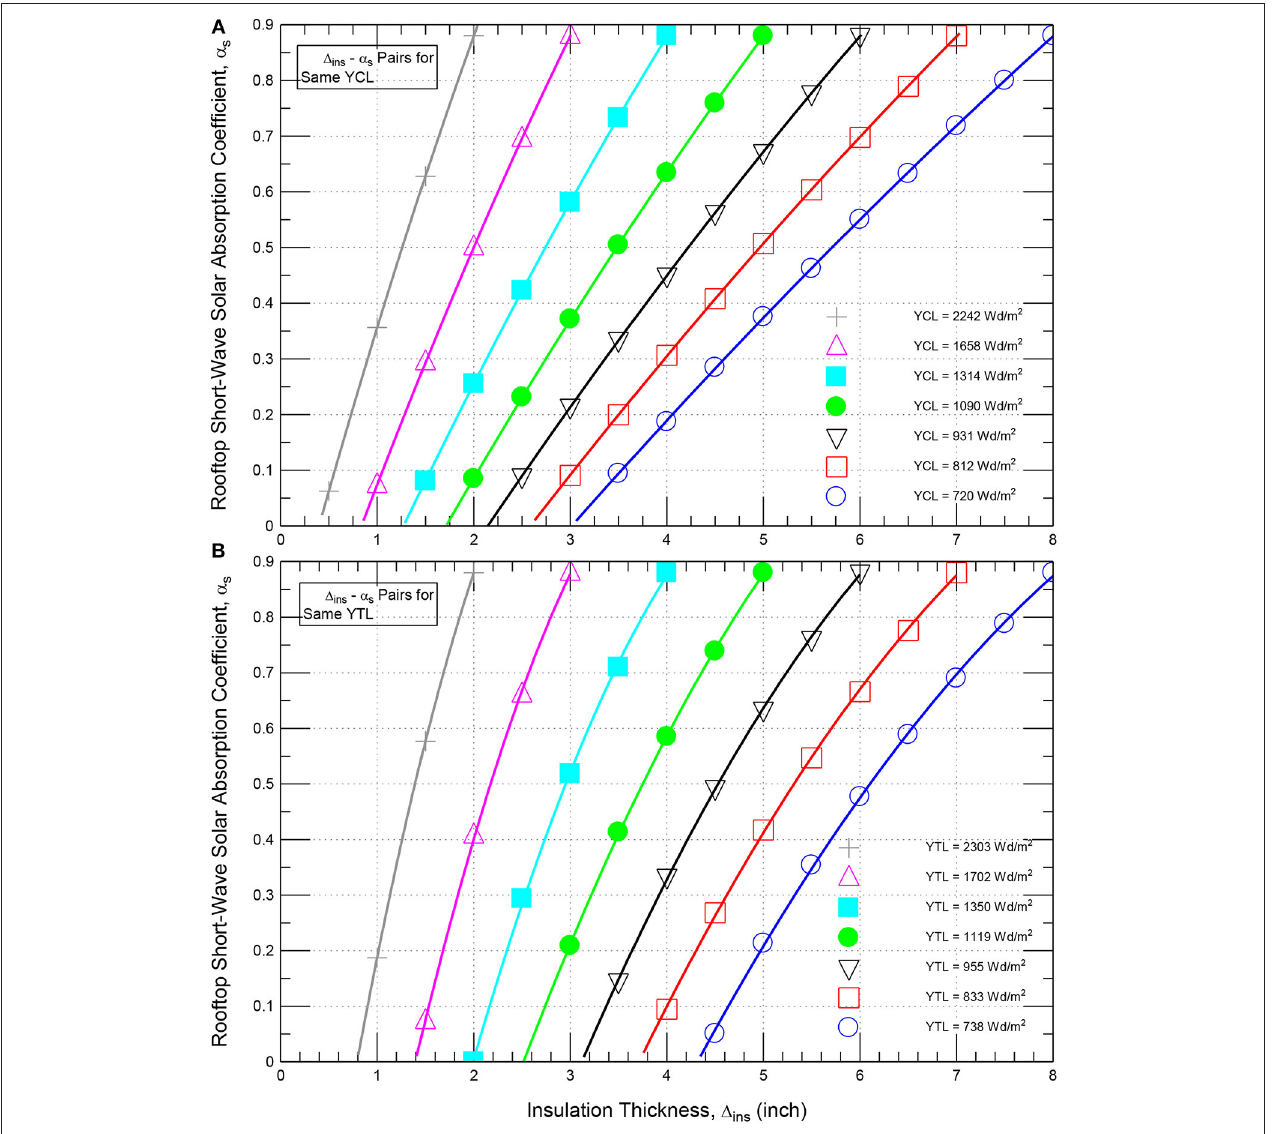
FIGURE 15 | Thermal insulation—short wave absorption coefficient pairs for the same contribution to: (A) yearly cooling energy loads and (B) yearly total energy